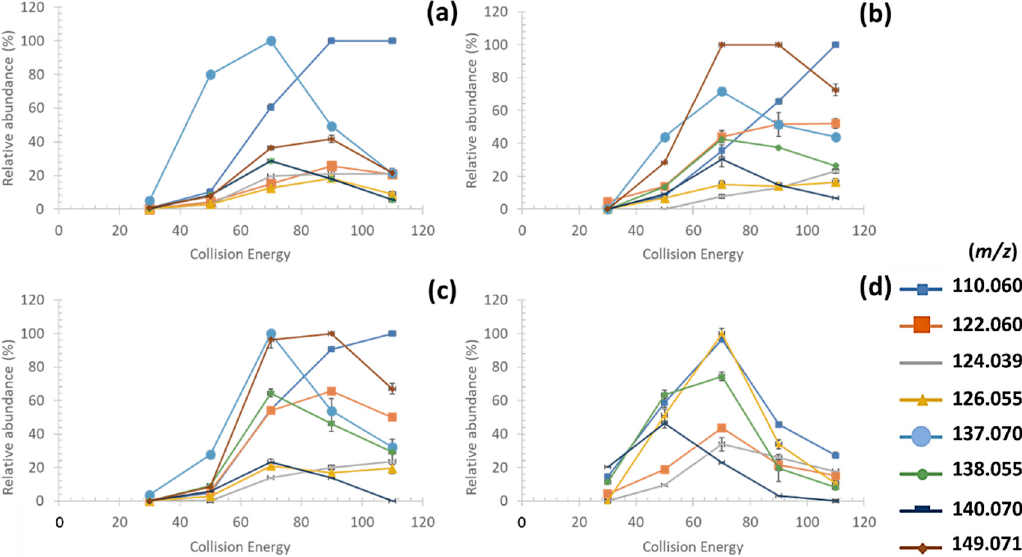
Figure 5. Relative abundance of characteristic fragment ions of MAAs depending on collision energies in MS² of palythine ( a ), porphyra-334 ( b ), shinorine ( c ) and mycosporine-serinol ( d ).